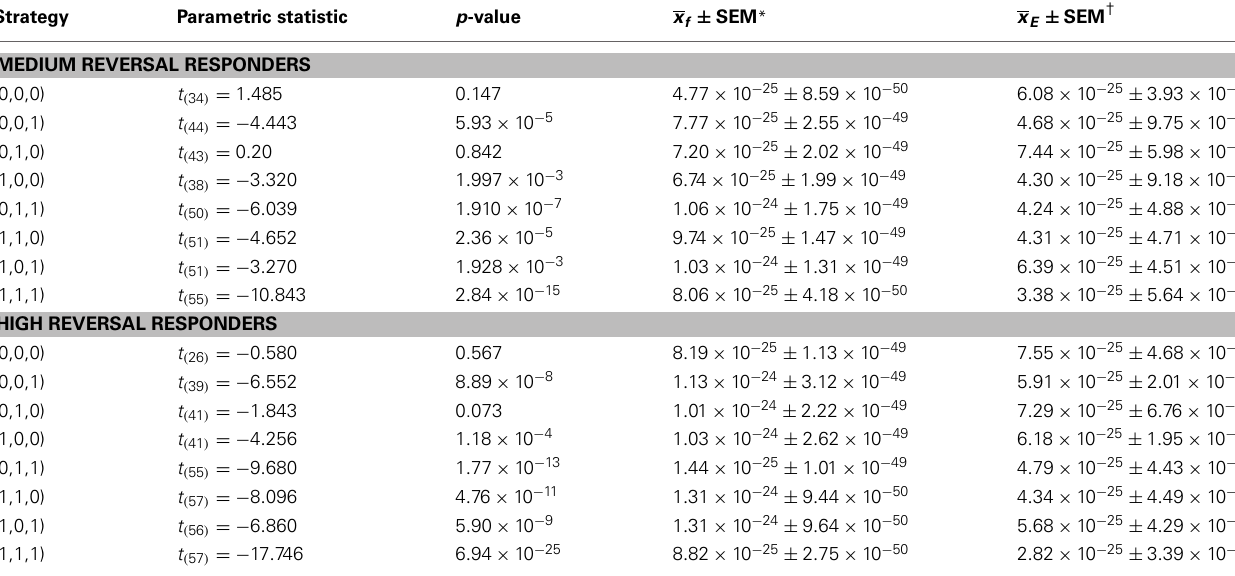
Table 2 | Comparisons of reversal Boltzmann entropies to bit-flip error thresholds. Strategy Parametric statistic MEDIUM REVERSAL